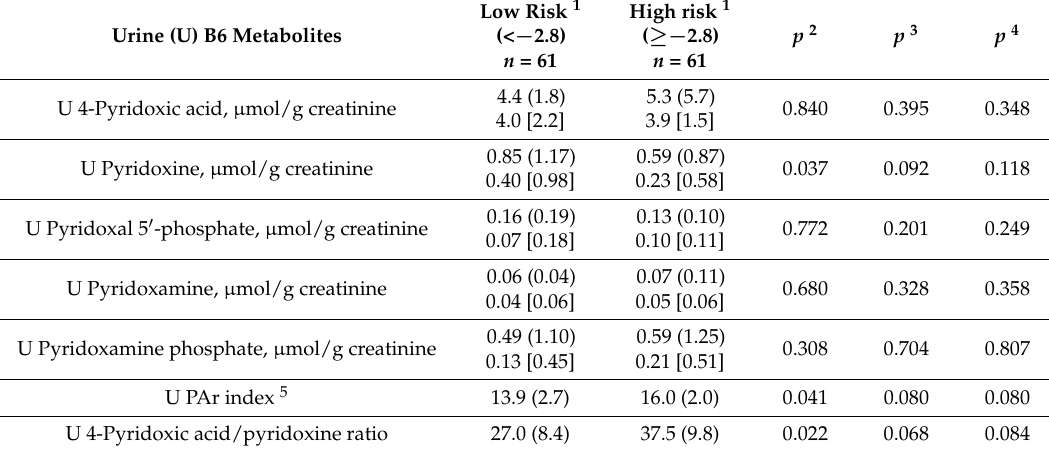
Table 3. Concentrations of urine vitamin B6 forms according to the risk score of cardiovascular hospitalization in 122 patients with type 2